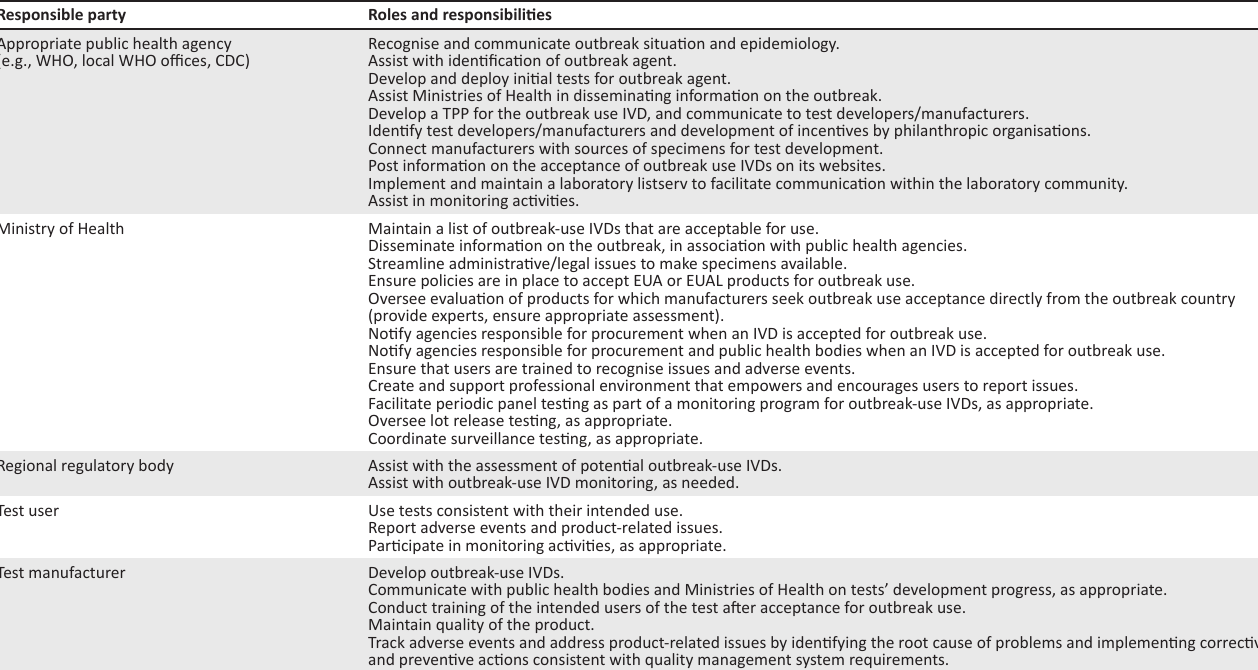
TABLE 1: Summary of roles and responsibilities for outbreak-use in vitro diagnostics Responsible